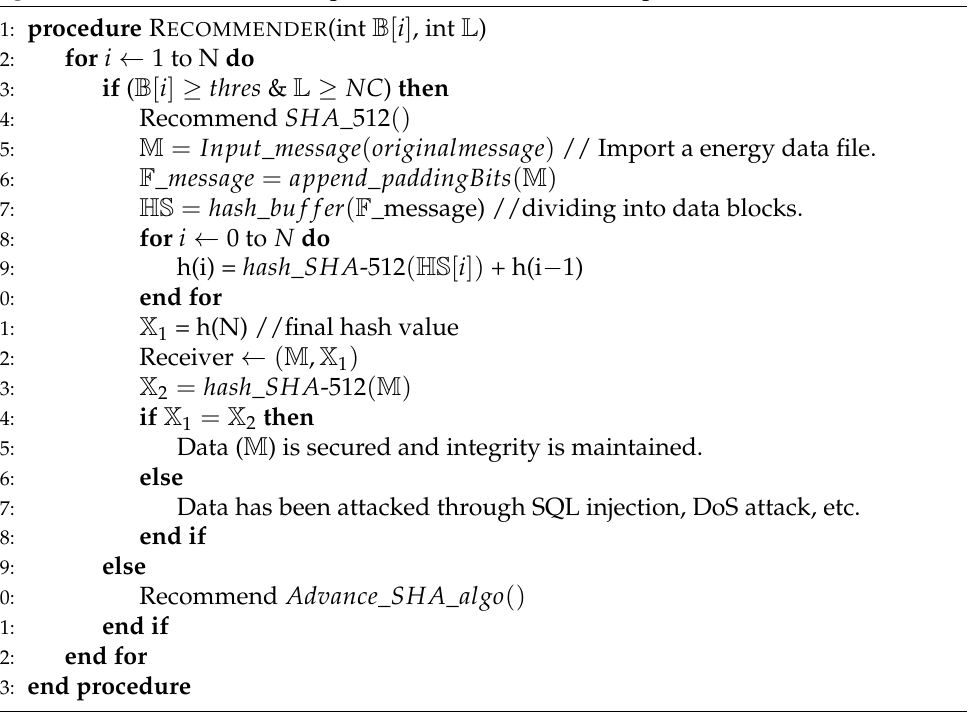
Algorithm 2 Recommend to implement SHA-512 for attack